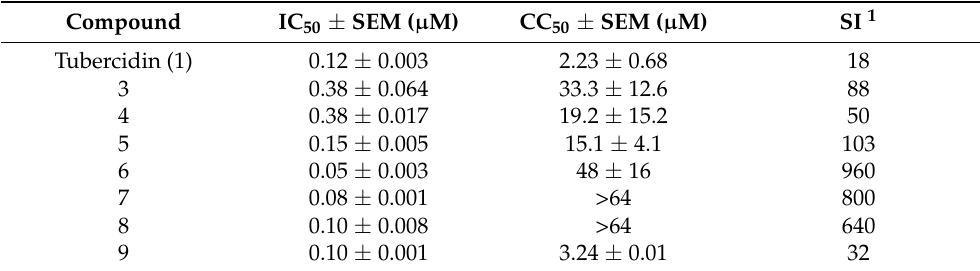
Table 1. Overview of the in vitro activity and cytotoxicity of the 7-deaza adenosine analogues